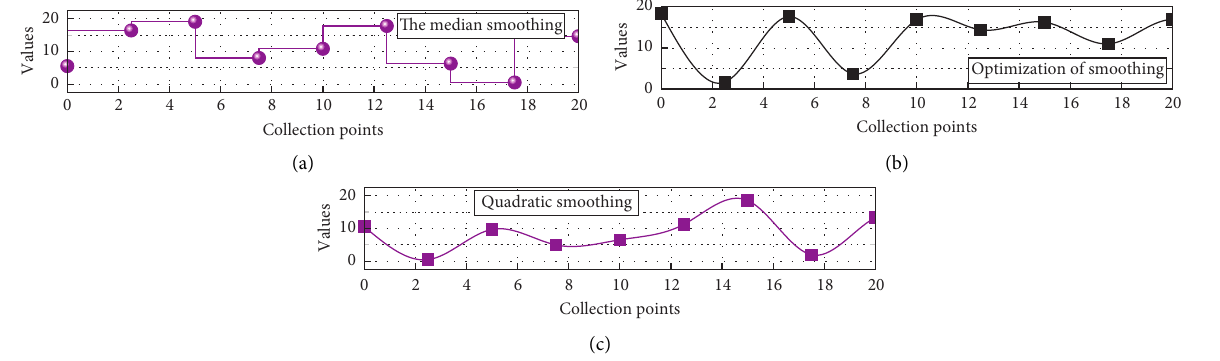
Figure 7: The effect of median smoothing and optimal smoothing.